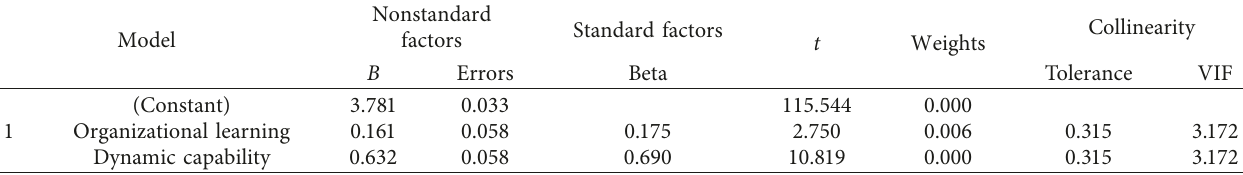
Table 3: VIF test results of variables.